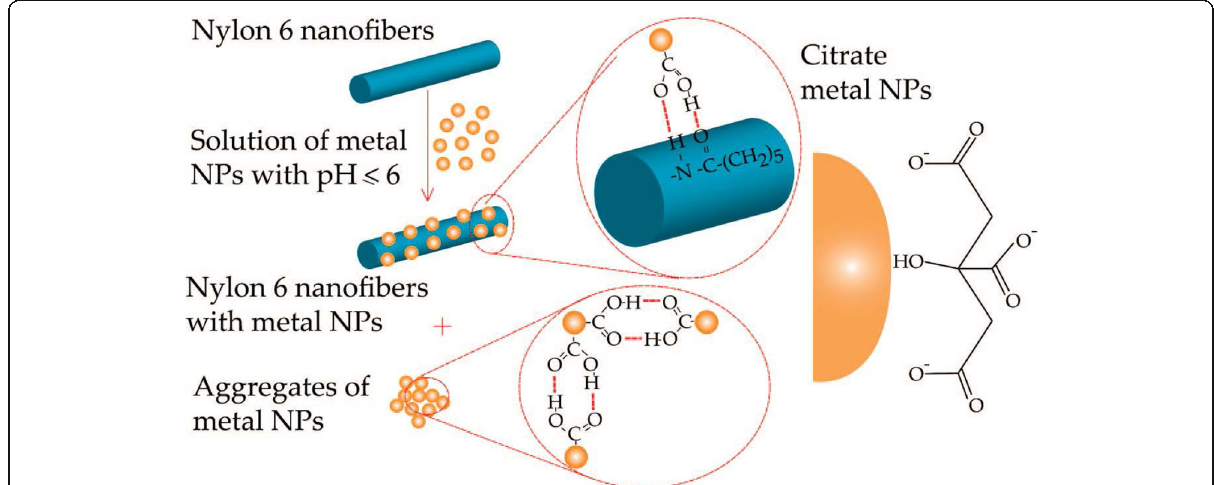
Fig. 5 Postulated mechanism of pH-induced assembly of metal nanoparticles on the surface of nylon 6 nanofibers [103]. Reprinted with permis- sion from ref. [103]. Copyright {2008} American Chemical